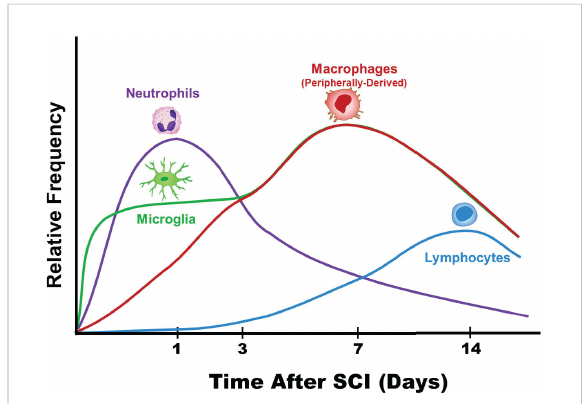
FIGURE 2 Patterns of immune cell in fi ltration following spinal cord injury. The order and timing (7, 27 – 31) of various immune cell in fi ltrates is depicted (32). The level of neutrophils peak at approximately 24 hours after SCI and decrease over the course of the next 7-10 days. Comparatively, lymphocytes peak much later and at lower levels compared to neutrophils. The resident macrophages, microglia, are early responders after SCI. Eventually, microglia become indistinguishable from the peripherally derived macrophages from a morphological